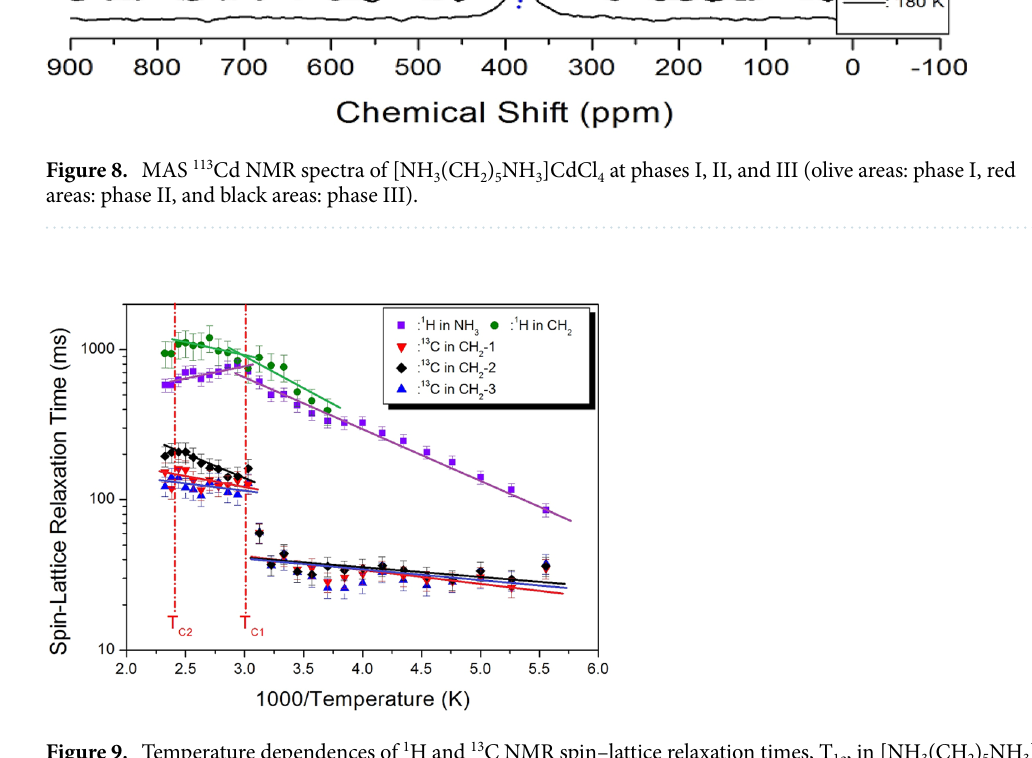
Figure 9. Temperature dependences of 1 H and 13 C NMR spin–lattice relaxation times, T 1ρ , in [NH 3 (CH 2 ) 5 NH 3 ] CdCl 4 near phase transition temperatures. Solid lines represent the activation